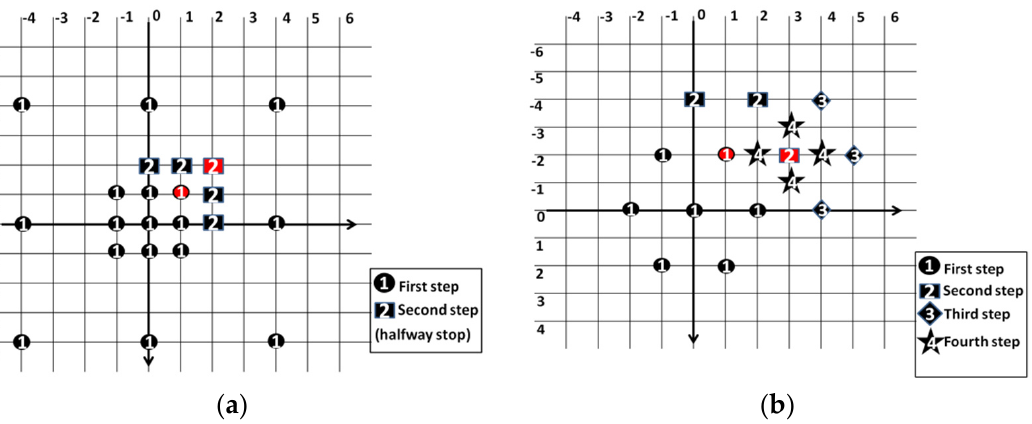
Figure 4. Motion vector searching procedure with an example, ( a ) using NTSS at (2, − 2), ( b ) using HS (3, − 2). Each search point is identified by a step number and a point with red colour indicates the minimum search point.